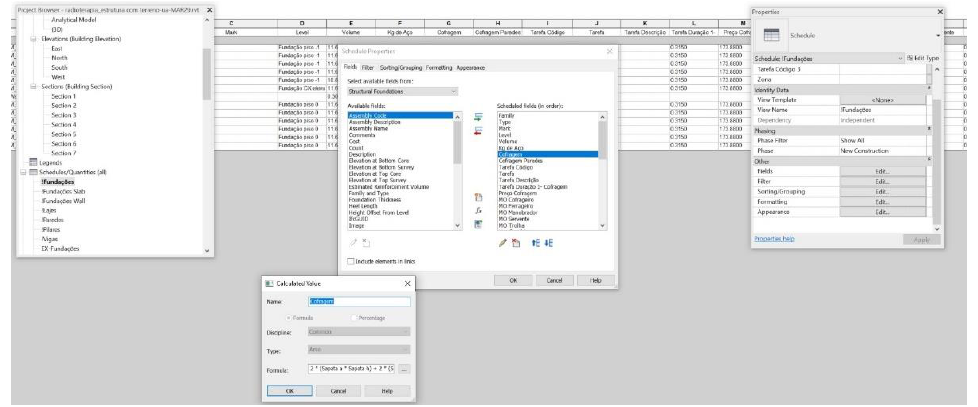
Figure 4. Definition of data for extraction in the spreadsheets template.